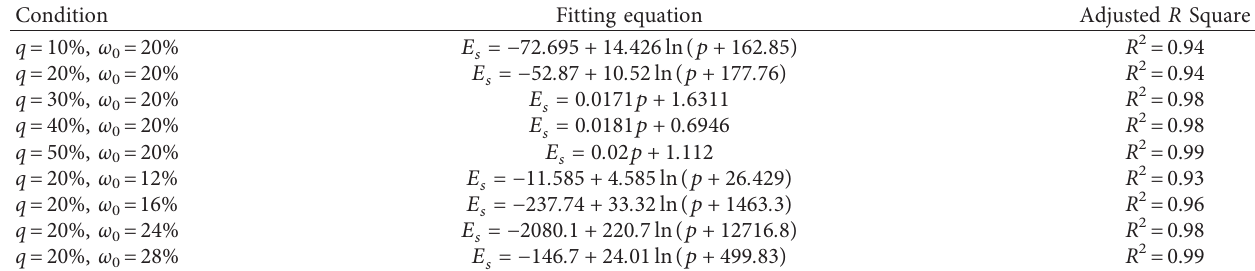
Table 3: Fitting results of E s - p curves.